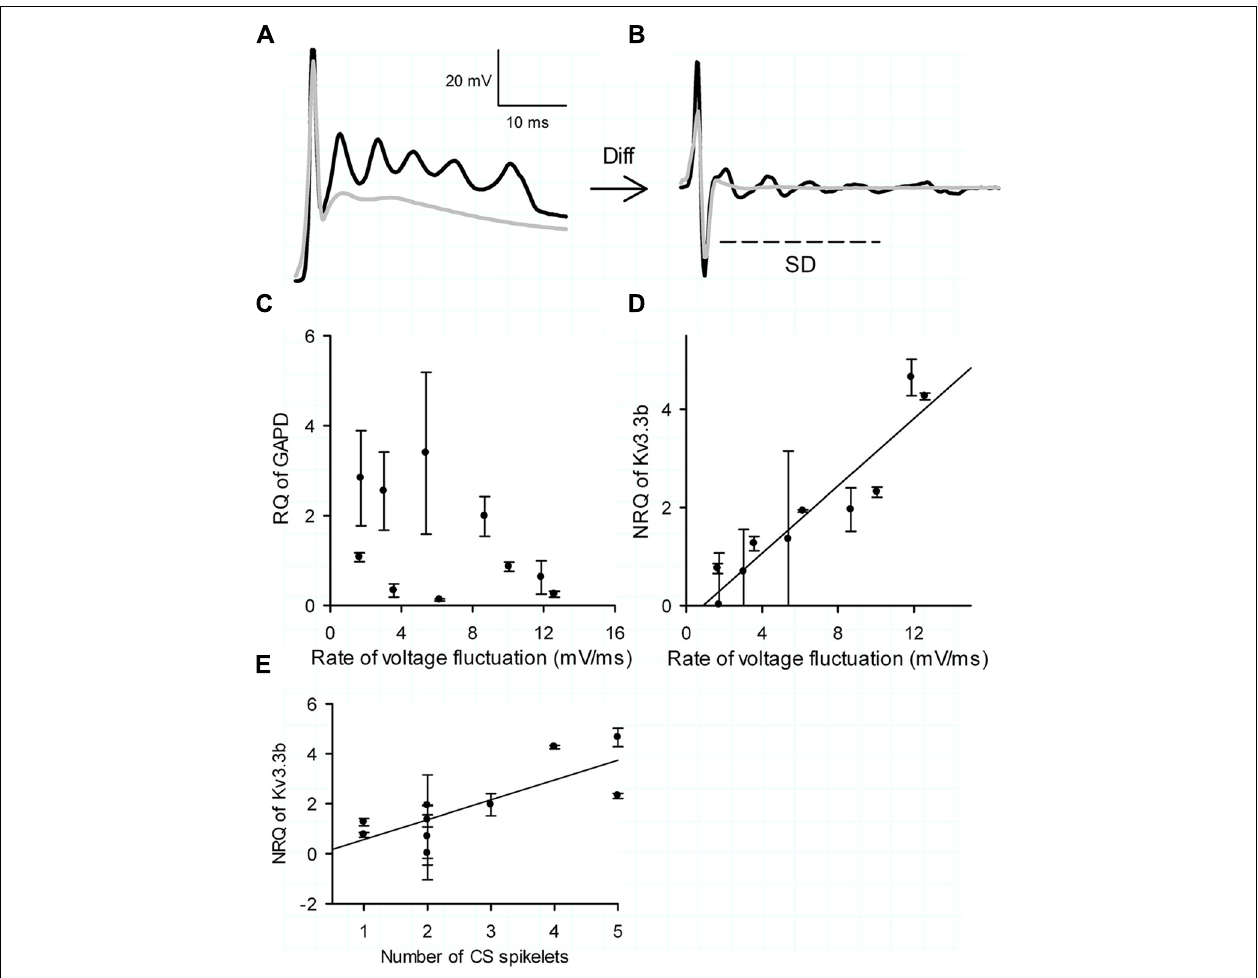
gene GAPD versus rate of voltage fluctuation. (D) Normalized relative expression (NRQ) of Kv3.3b versus rate of voltage fluctuation. (E) NRQ of Kv3.3d versus number of CS spikelets.The error bars in (C,D) were determined through calculating the error propagation of the normalized or non-normalized relative quantity of the Kv3.3b real time PCR